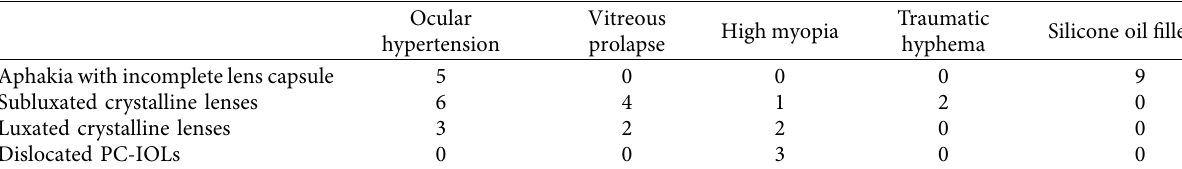
Table 2: Characteristics.